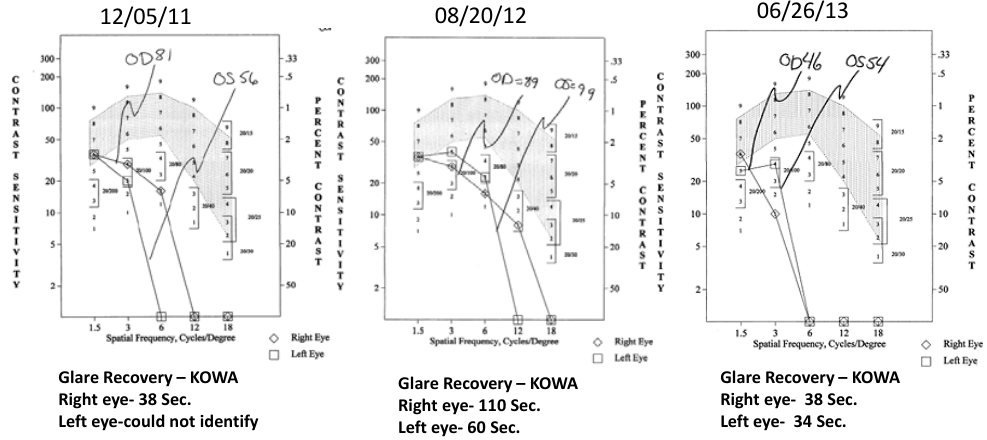
Figure 8. Contrast Sensitivity and Glare Recovery of an 89-year-old male patient with AMD. The contrast sensitivity and glare recovery function right eye are stable, while his left eye has progressive dramatically improved glare recovery (in seconds). Both eyes have an abnormally prolonged glare recovery time that improved but was still abnormal. Expected is 10 to 12 s, in individuals without retinal pathology. This is opposite of the anticipated aging and pathophysiological decline. Baseline Snellen visual acuity was 20/40 in each eye and remained unchanged over 2.5 years allowing the octogenarian to maintain an unrestricted driver’s